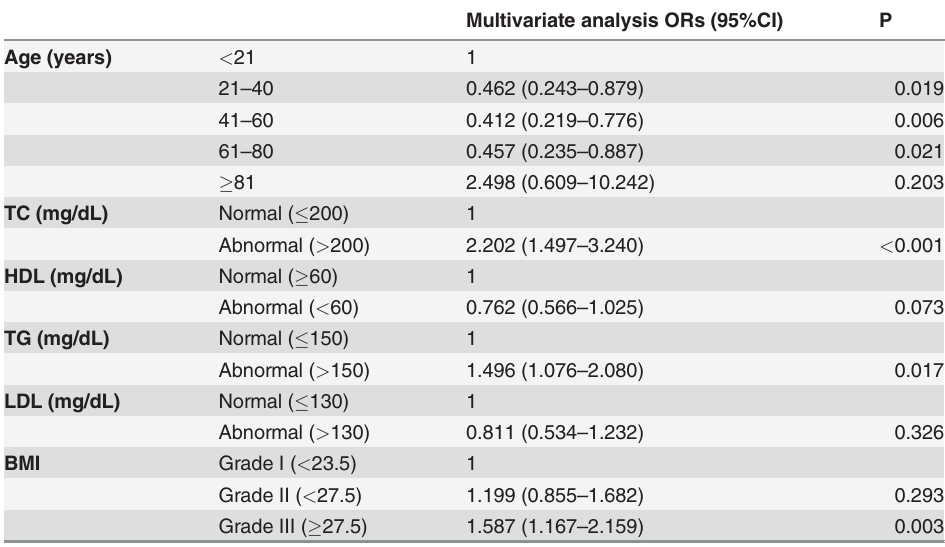
Table 3. Analysis of lipid profiles as risk factors for sudden sensorineural hearing loss by multivari- able logistic